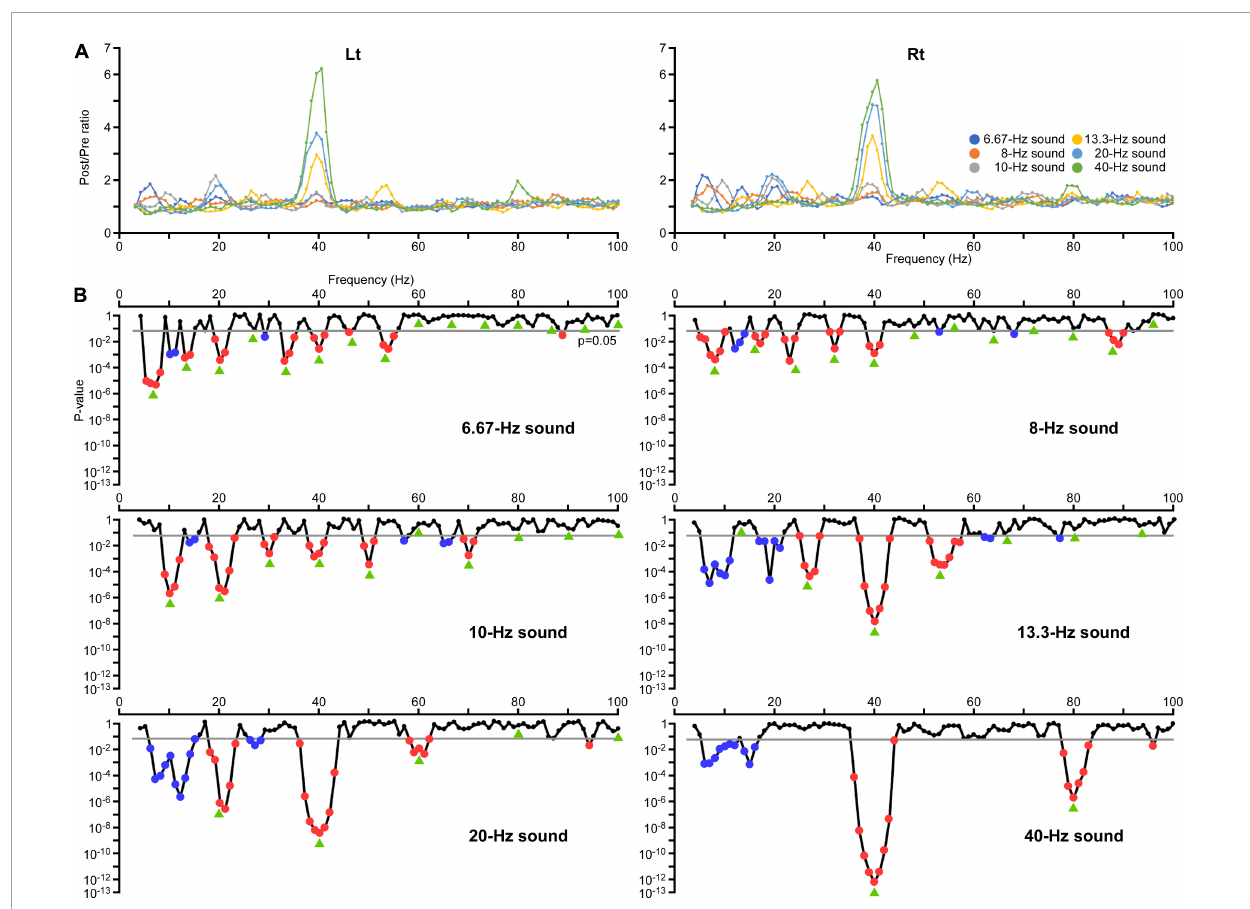
FIGURE2 Changes in the inter-trial phase coherence (ITPC) of oscillations. (A) The effects of modulation of the oscillation in ITPC at all frequency sampling points. The vertical axis indicates the ratio of the average ITPC at 200–1,000 ms (Post) relative to the baseline (Pre). (B) The results of two-way ANOVA. The vertical axis indicates the p -values for the effect of PrePost obtained in each condition. Significant increases in the amplitude are indicated by red dots and decreases are indicated by blue dots. Green arrows indicate harmonic frequencies in each condition.